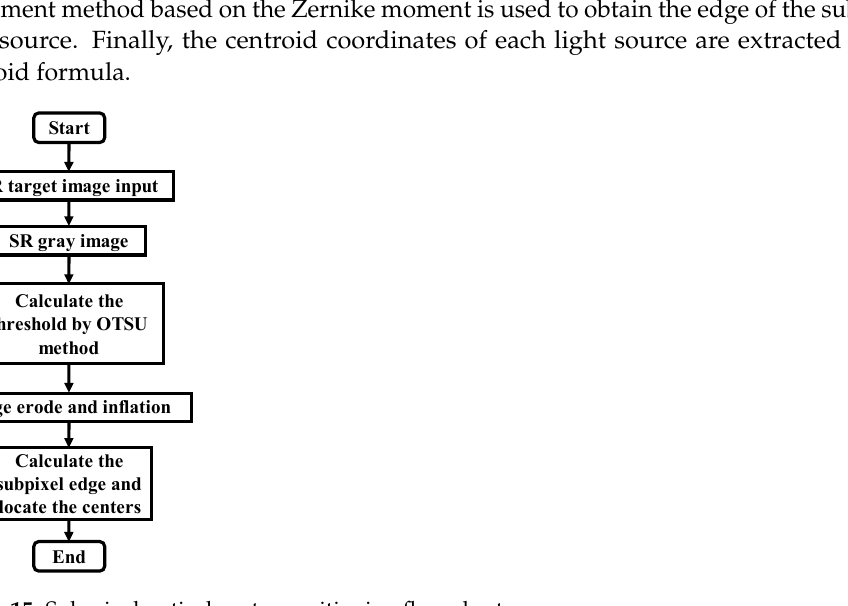
Figure 15. Sub-pixel optical center positioning flow chart.